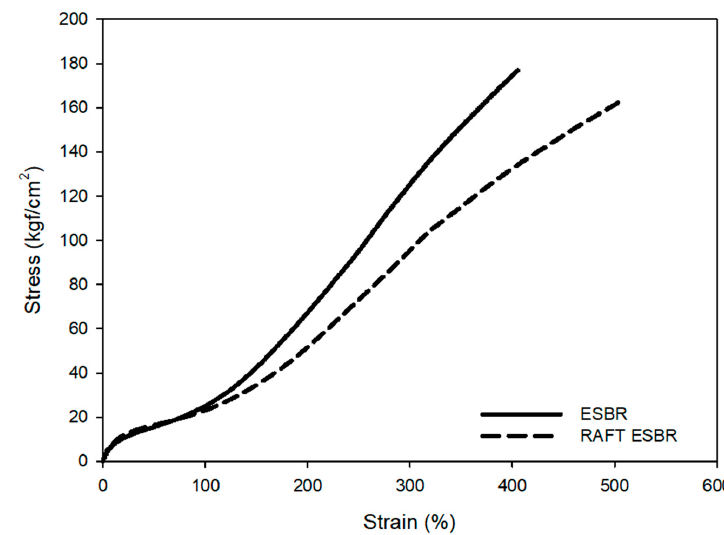
Figure 9. Mechanical properties of vulcanizates of emulsion styrene butadiene rubber (ESBR) and